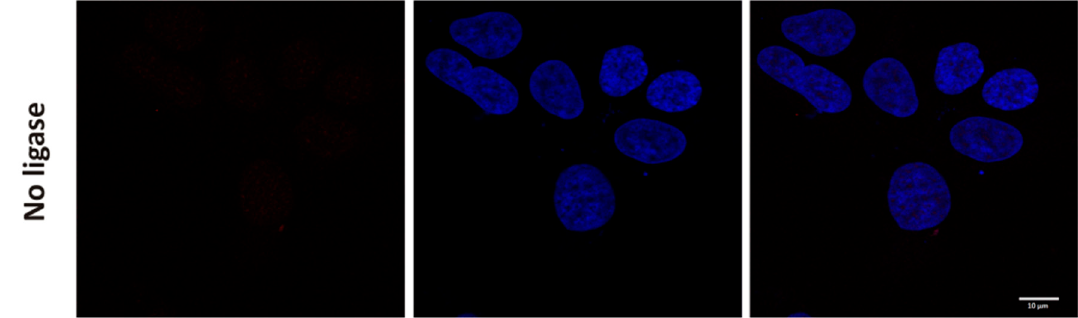
Figure 7. Presence of complexes formed between α -synuclein and CacyBP / SIP or HSP90 in HEK293 cells visualized by PLA (representative images). Complexes of examined proteins are shown as red dots; cell nuclei, stained with DAPI, are in blue. HSP90 was used as a positive control. Scale bar–10 µm.